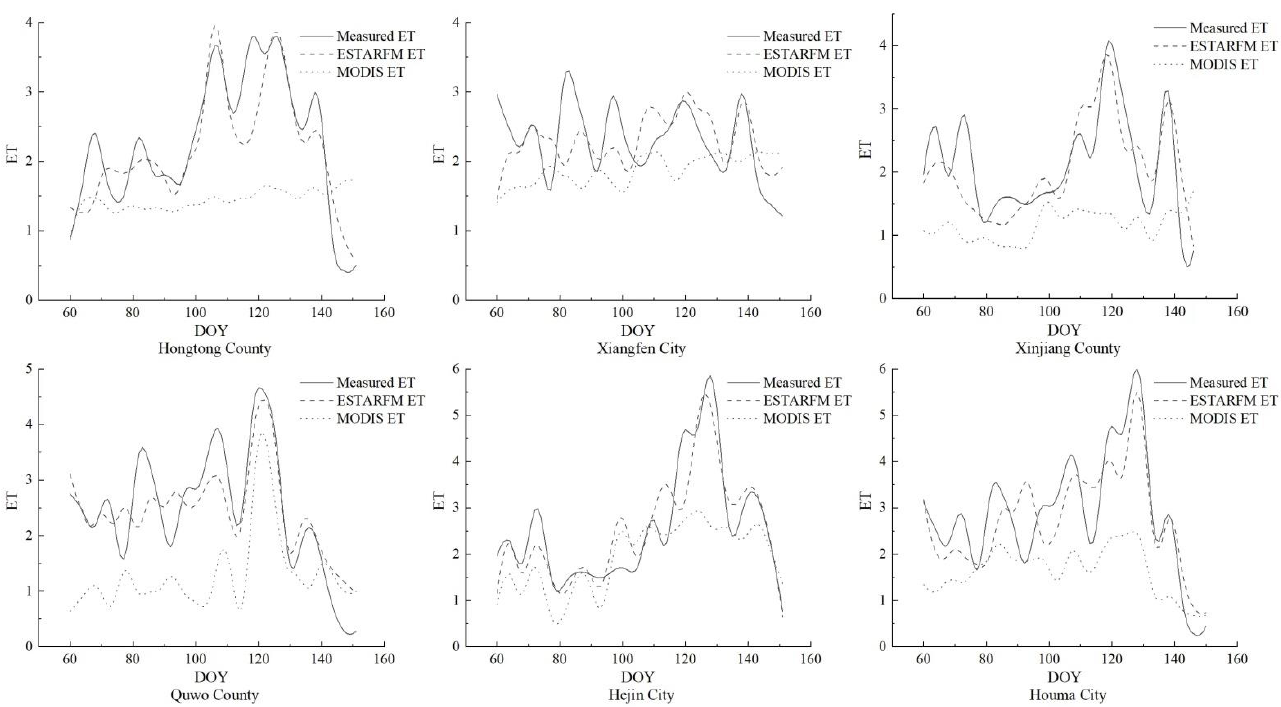
Figure 4. Time-series variation of measured, ESTARFM, and MODIS evapotranspiration (ET) during the main growth stage of winter wheat in Hongdong County, Xiangfen County, and Xinjiang County for dry farming samples and Quwo County, Hejin City, and Houma City for irrigation sam- ples.